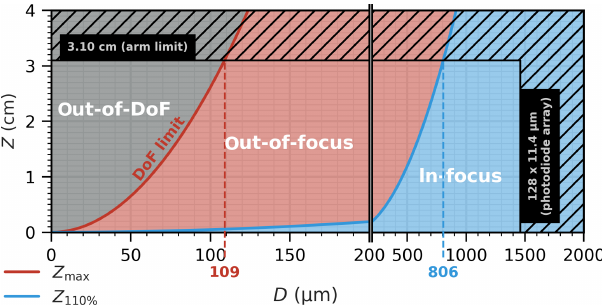
Figure 4. Depth of field (DoF) limit (distance Z max from the object plane) separating out-of-DoF and out-of-focus regions, and in-focus limit (distance Z 110% from the object plane where the external di- ameter of the diffraction pattern appears with 110% magnification) separating out-of-focus and in-focus regions, for an opaque disc with diameter D measured with the two-dimensional stereo (2D- S) probe. The hatched area illustrates the arm limit and the 128- photodiode array